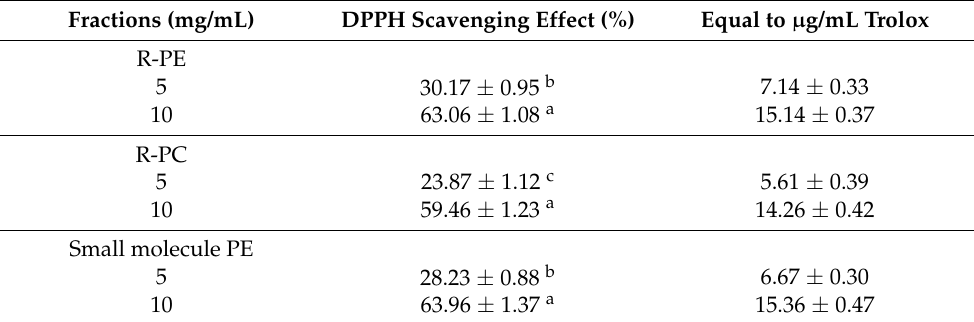
Table 4. DPPH free radicals scavenging effect of phycobiliprotein extracts from